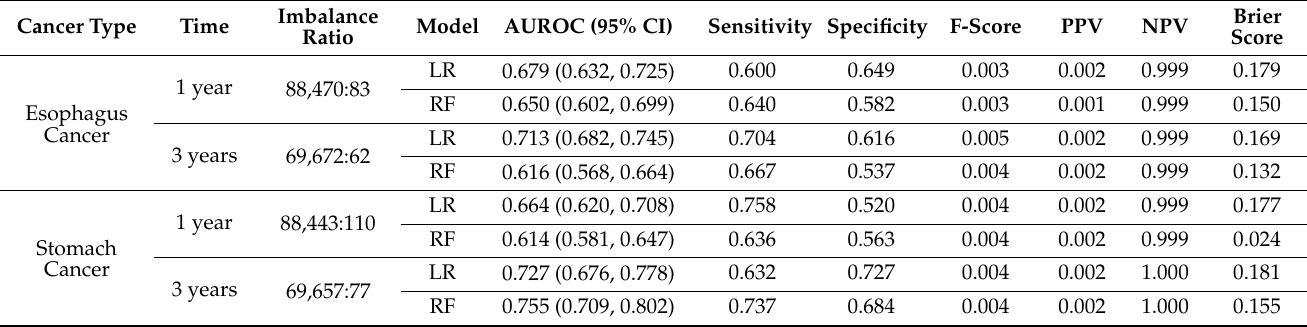
Table A2. Subanalysis by cancer type. (AUROC = Area Under the Receiver Operating Curve, PPV = Positive Predictive Value, NPV = Negative Predictive Value, Imbalance Ratio = number of negative samples: number of positive samples, LR = Logistic Regression, RF = Random